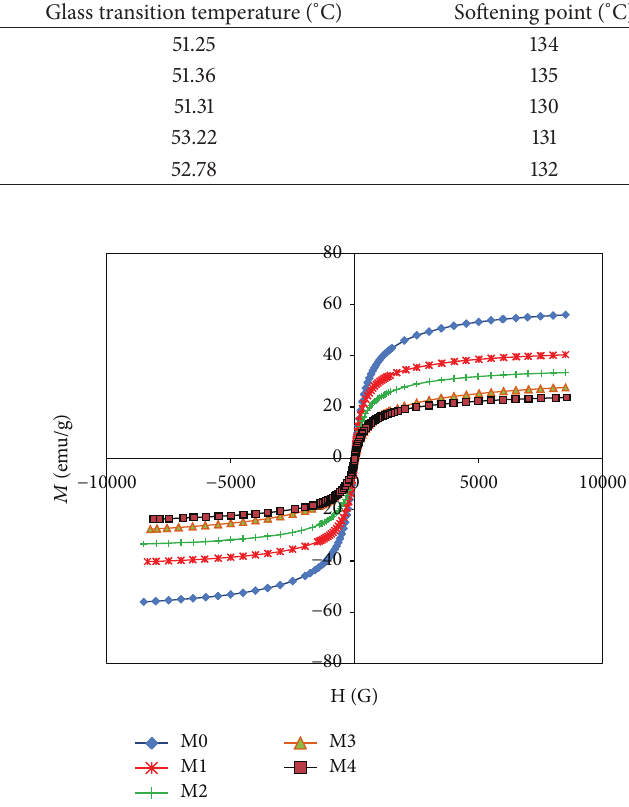
Figure 5: Magnetite properties of synthesize Fe 3 O 4 particles with various amounts of surfactant.